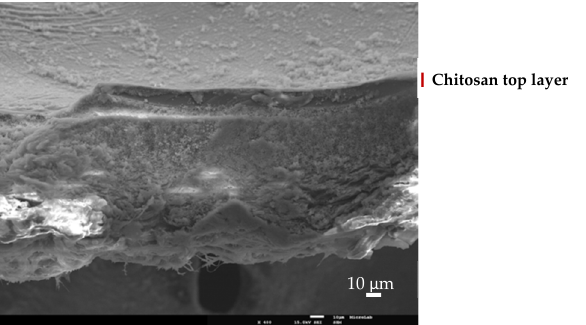
Figure 1. Scanning Electronic Microscopy (SEM) image of the cross-section of a chitosan modi- fied membrane, cs-PES MF022, obtained after filtration of the synthetic tannery effluent (adapted from